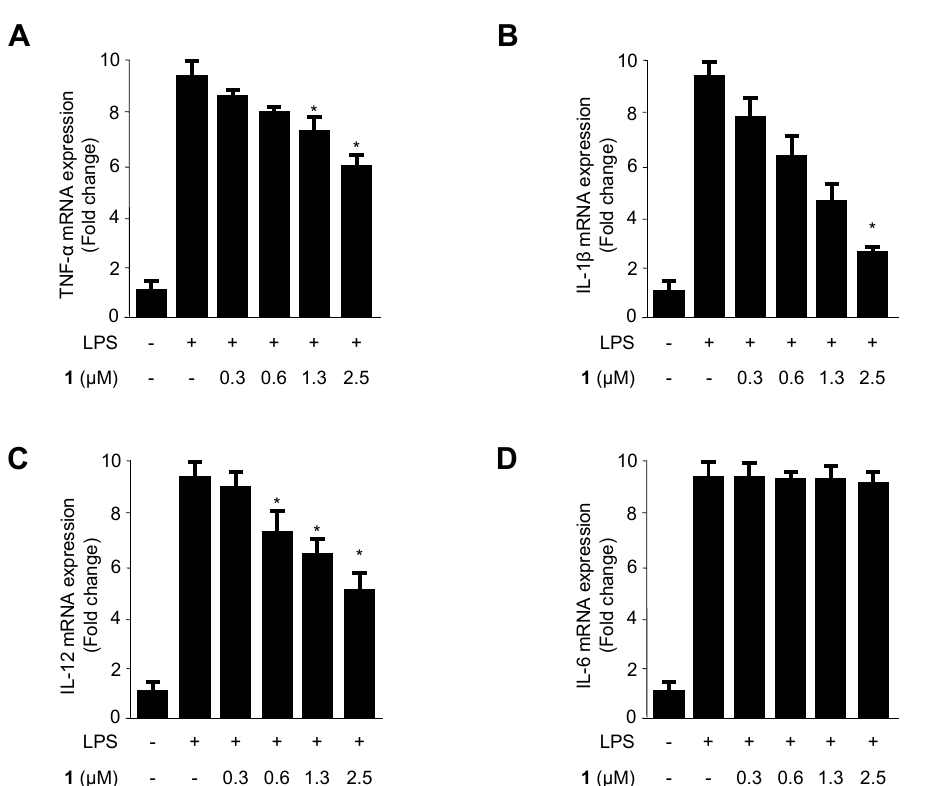
Figure 3. The effects of cudratricusxanthone A ( 1 ) on TNF- α ( A ); IL-1 β ( B ); IL-12 ( C ); and IL-6 ( D ) mRNA expression in LPS-stimulated BV2 cells. Cells were pretreated for 3 h with the indicated concentrations of cudratricusxanthone A ( 1 ) and then stimulated for 12 h with LPS (1 µg/mL). The LPS treatment was performed in the presence of compound. The concentrations of TNF- α ( A ), IL-1 β ( B ); IL-12 ( C ); and IL-6 ( D ) were determined as described in the Experimental Section. RNA quantification was performed as described in the Experimental Section, and representative blots of three independent experiments are shown. The data represent the means ± SDs of three experiments. * p < 0.05 compared with the group treated with LPS. “+” is treated, “ − “ is not treated.